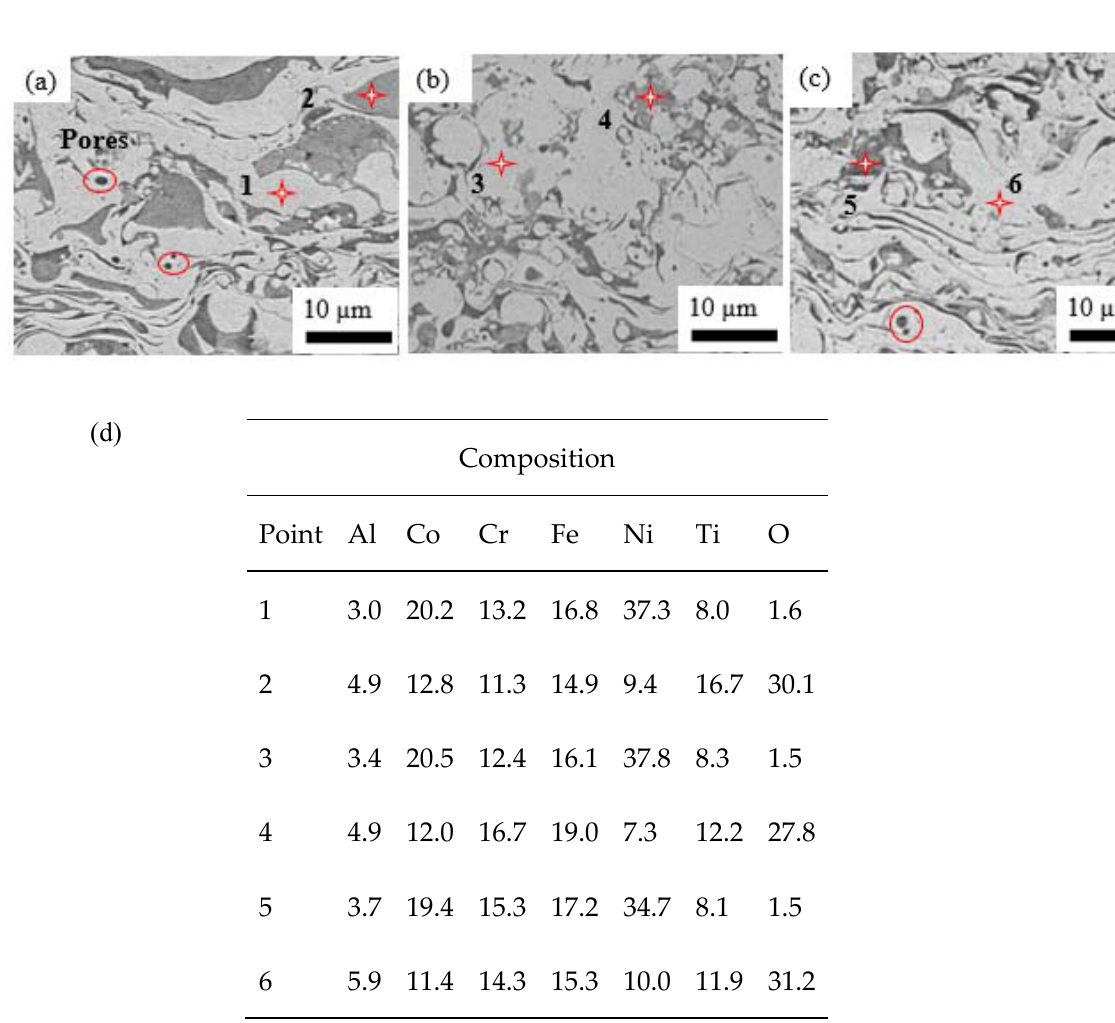
Figure 4. SEM microstructure of the as-sprayed coatings: ( a ) low power, P 500 /H 0 ; ( b ) medium power P 600 /H 0 ( c ) high power, P 700 /H 0 ( d ) Elemental composition at P 500 /H 0 P 600 /H 0 , and P 700 /H 0 .